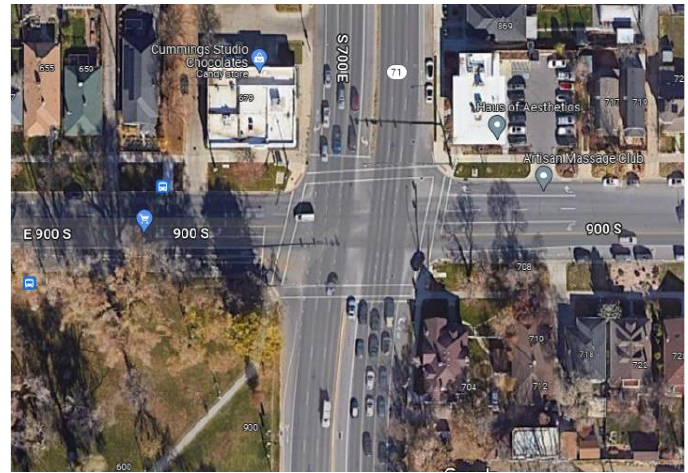
Figure 6. Intersection 700 East and 900 South, Salt Lake City. (Source: Google Maps)